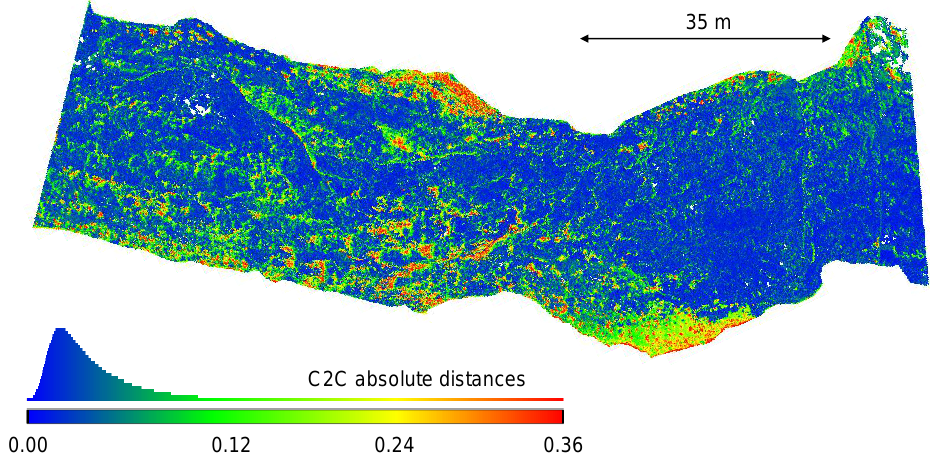
Figure 8. Cloud-to-cloud absolute distances, computed between the HERON Lite model and the photogrammetric point cloud, for the reach of Vegliato torrent.